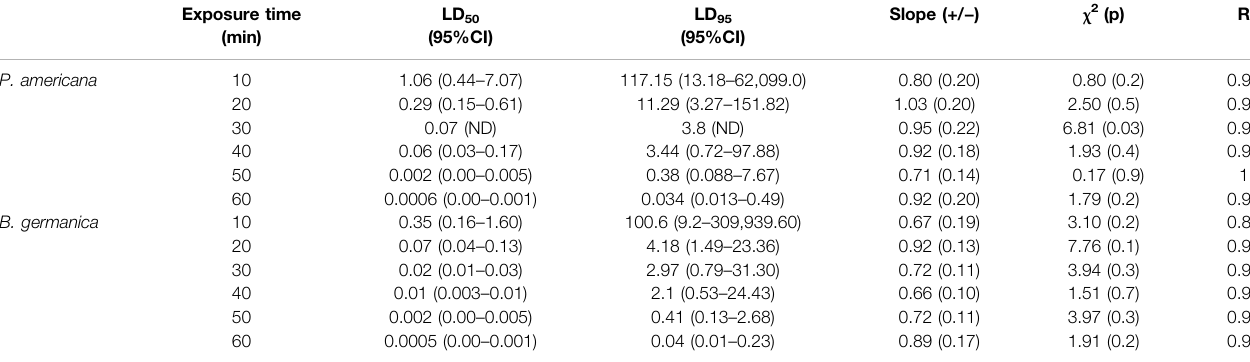
TABLE 2 | Lethal dose (LD) values of P. americana and B. germanica for deltamethrin exposure to different time periods. Exposure time (min)